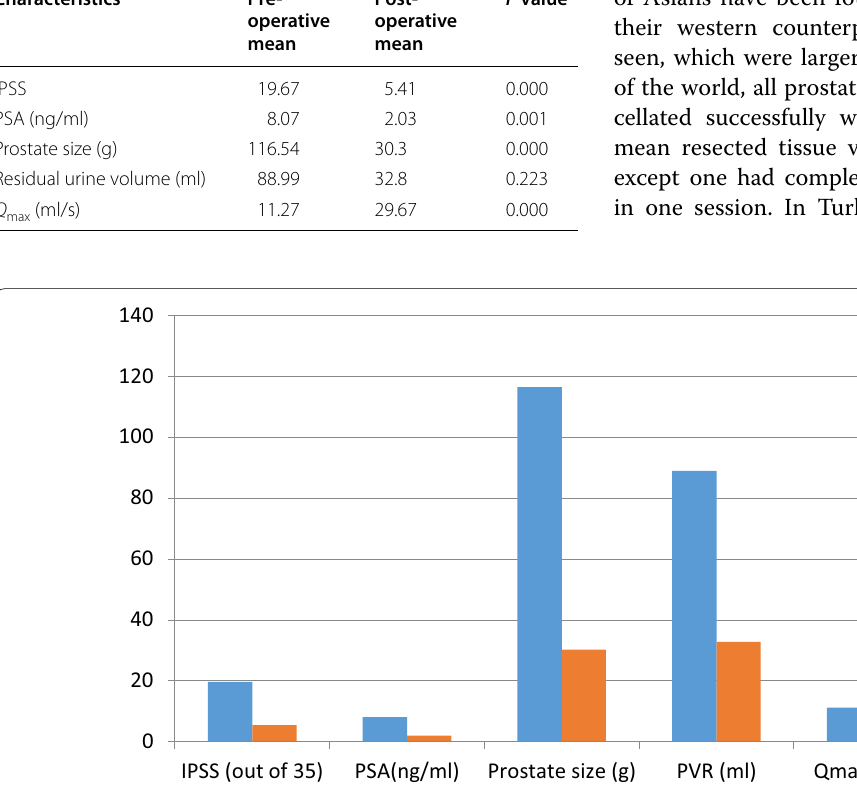
Table 3 Post-operative characteristics Characteristics